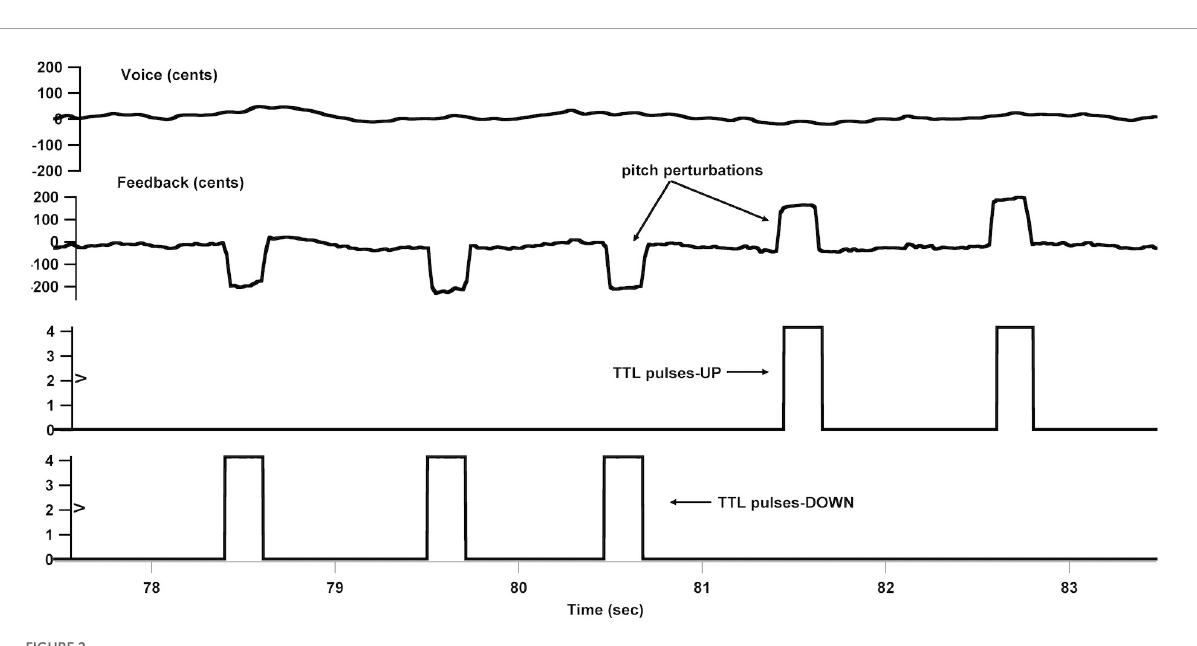
the transistor-transistor logic (TTL) control pulses to mark the onset of each perturbation. Finally, the pitch-shifted voice signals were amplified by an ICON NeoAmp headphone amplifier (Middleton, WI) and fed back to participants through insert earphones (ER-1, Etymotic Research Inc., Elk Grove Village, IL). The original and pitch-shifted voice signals as well as the TTL pulses were digitized by a PowerLab A/D converter (ML880, AD Instruments) and recorded at 10 kHz using LabChart software (v.7.0, AD Instruments, New South Wales,